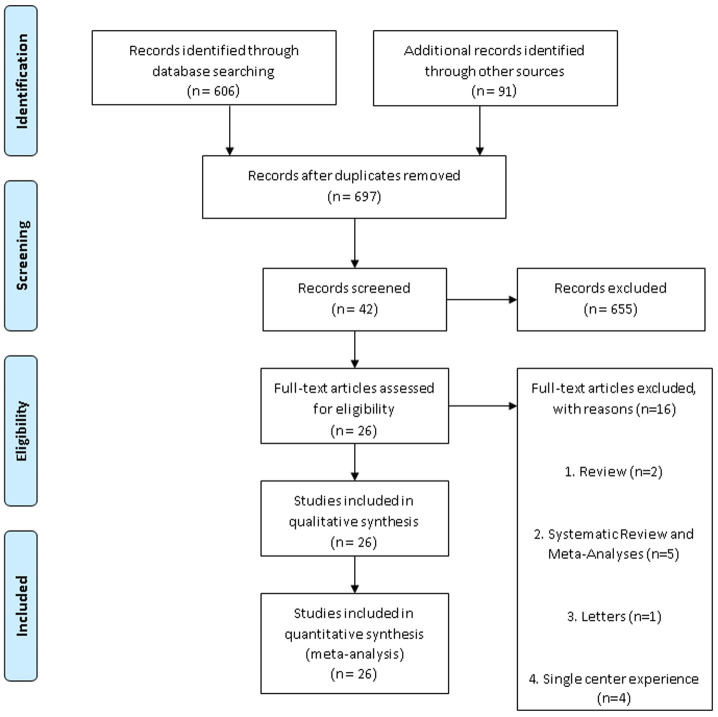
Study selection.